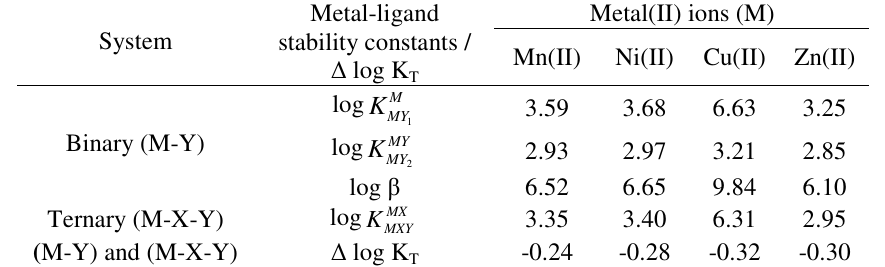
Table 1. Metal-ligand stability constants of binary (M-Y), ternary (M-X-Y) systems and